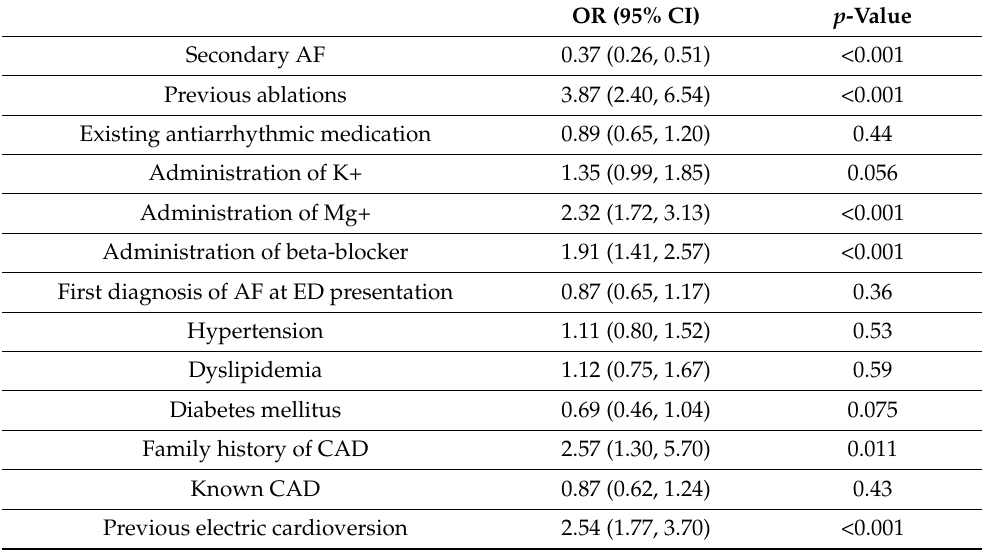
Table 2. Summary of age and sex adjusted logistic regressions for restoration of sinus rhythm during hospital